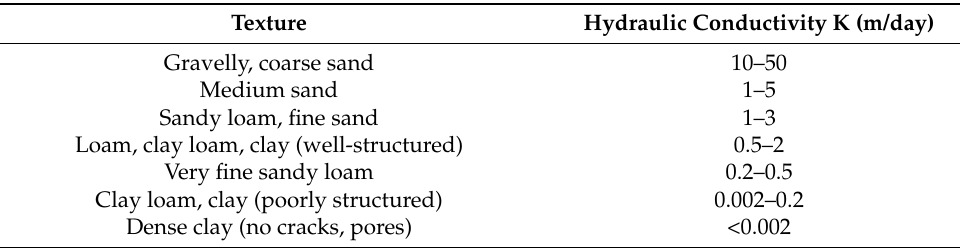
Table 4. Hydraulic conductivity: K-value range by soil